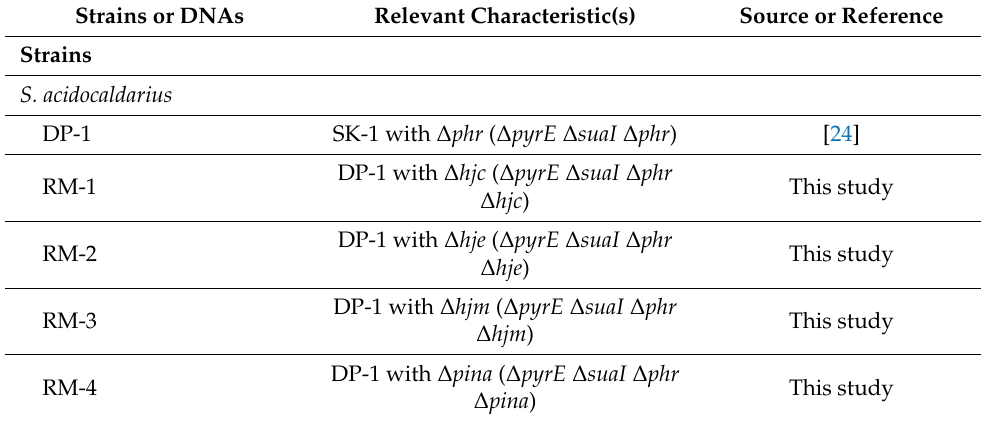
Table 1. Strains or DNA used in this